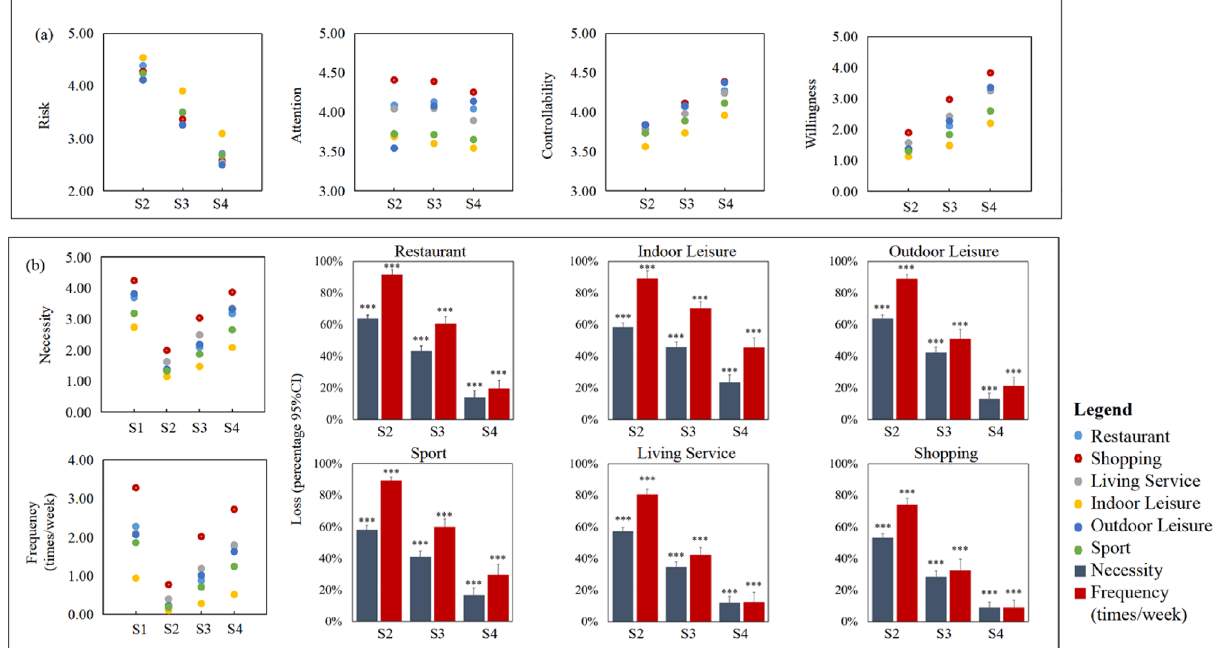
Figure 3. Changes over four stages. ( a ) Changes of perception. ( b ) Loss of necessity and frequency (times/ week) during stage2 to stage4. ***p < 0.001, the comparison of stage n and stage1 (n = 2, 3,